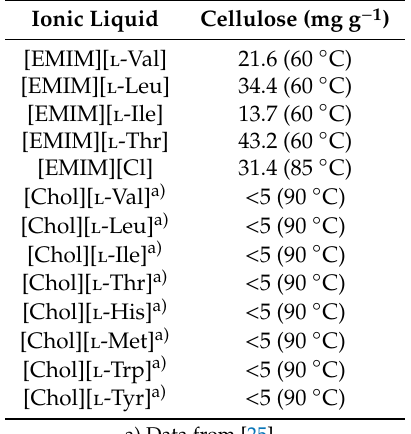
Table 6. The solubility of cellulose in [EMIM][AA] and [Chol][AA] ILs. Ionic